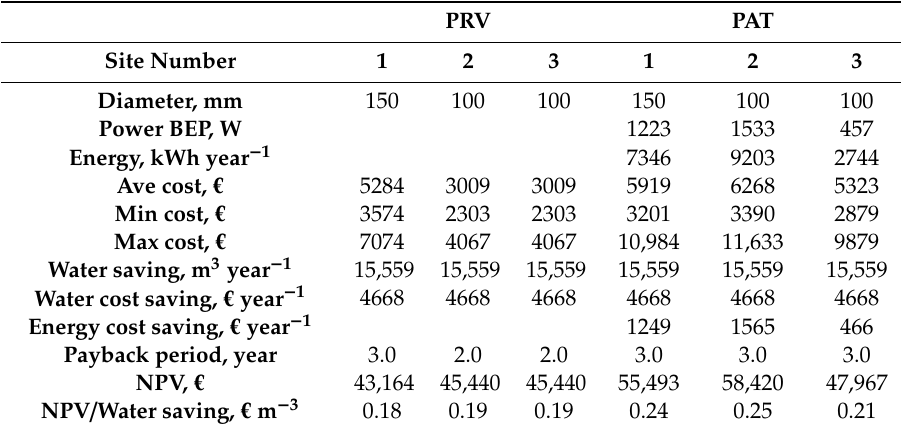
Table 3. PRV / PAT analysis in Ballinabranna Group Water Scheme